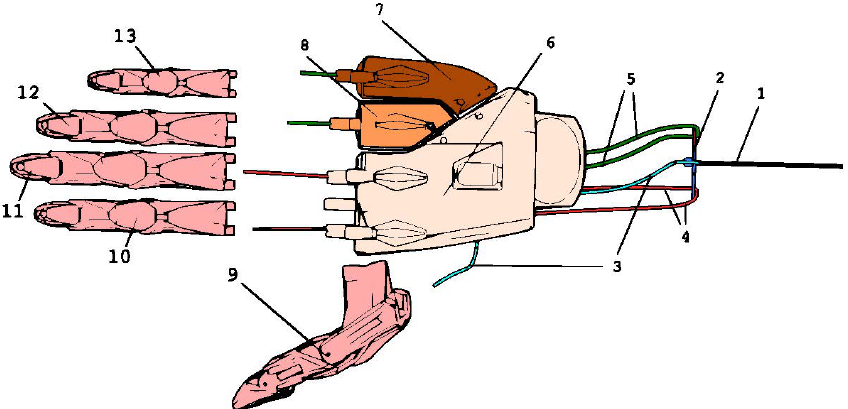
Figure 2. Complete illustration of the design: (1) Main rope. (2) Force distributor. (3) Thumb rope. (4) Index and middle finger rope. (5) Ring and little finger rope. (6) Palm. (7) Fifth metacarpus. (8) Fourth metacarpus. (9) Thumb. (10) Index finger. (11) Middle finger. (12) Ring finger. (13) Little finger.